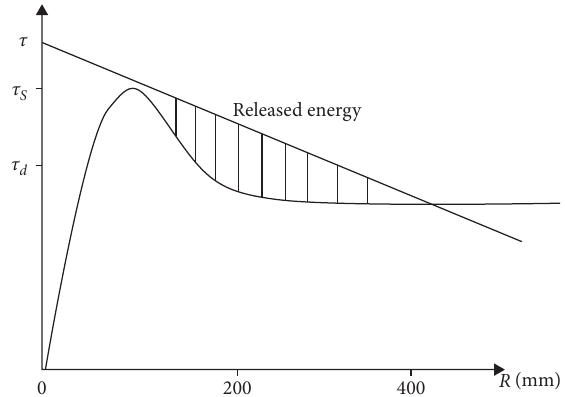
Figure 11: Schematic diagram of energy released by a fault slip [26].